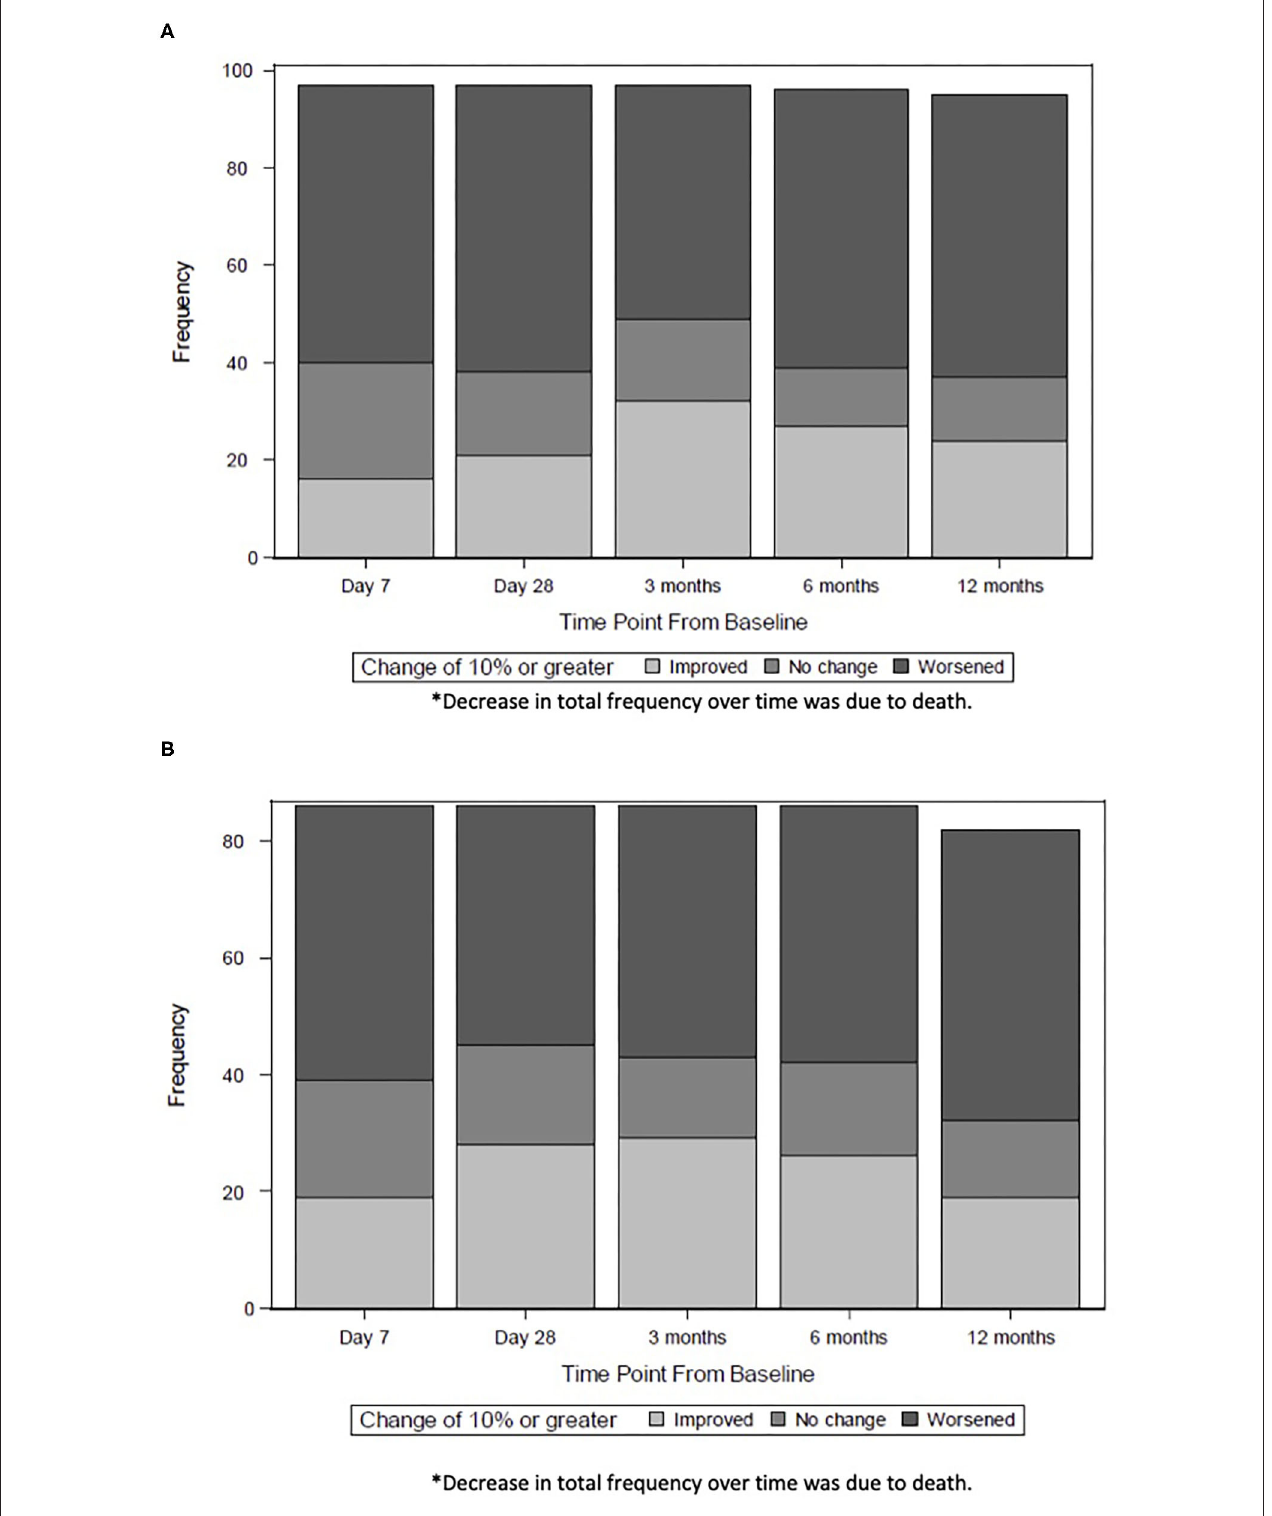
FIGURE 2 | (A) Trajectory of HRQL For Children without Severe Developmental Delay*. The number of children without severe developmental delay who exhibited at least 10% improvement in HRQL peaked at 3 months (32 children) and decreased by 12 months (23 children). (B) Trajectory of HRQL for Children with Severe Developmental Delay*. The number of children without severe developmental delay who exhibited at least 10% improvement in HRQL peaked at 3 months (29 children) and decreased by 12 months (16 children). *Decrease in total frequency over time was due to death.